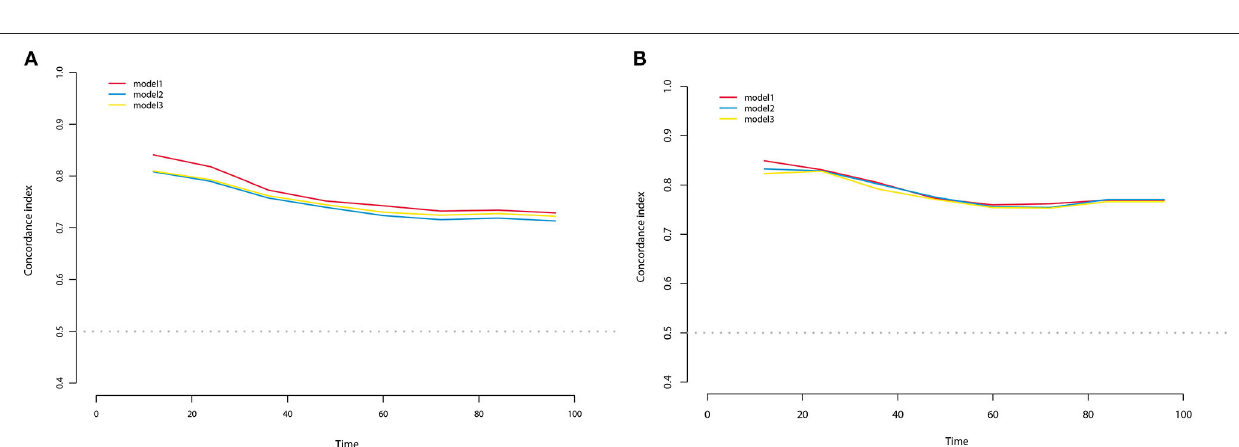
FIGURE 2 | C-index for OS (A) and CSS (B) at different time of three nomogram models in the training